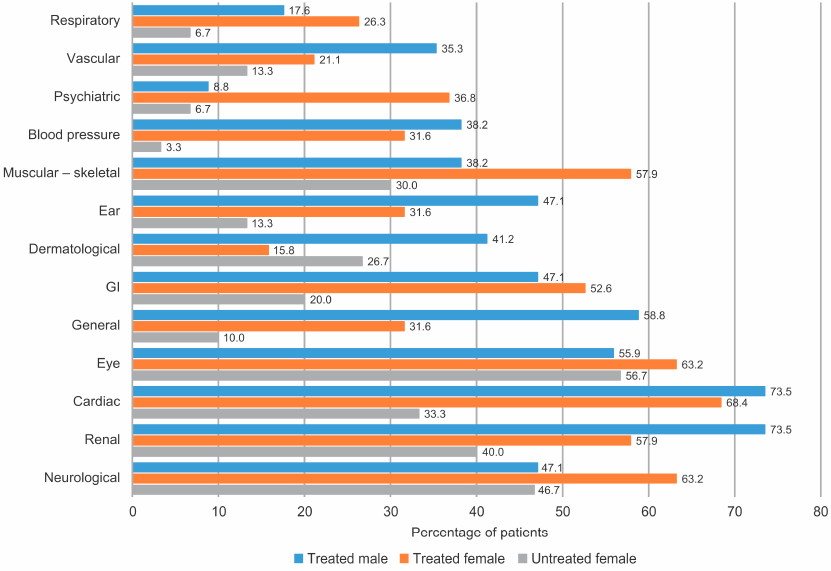
Figure 1. Comparison of patients by organs affected in treated males and females and untreated females. FOS, Fabry Outcome Survey; GI, gastrointestinal.